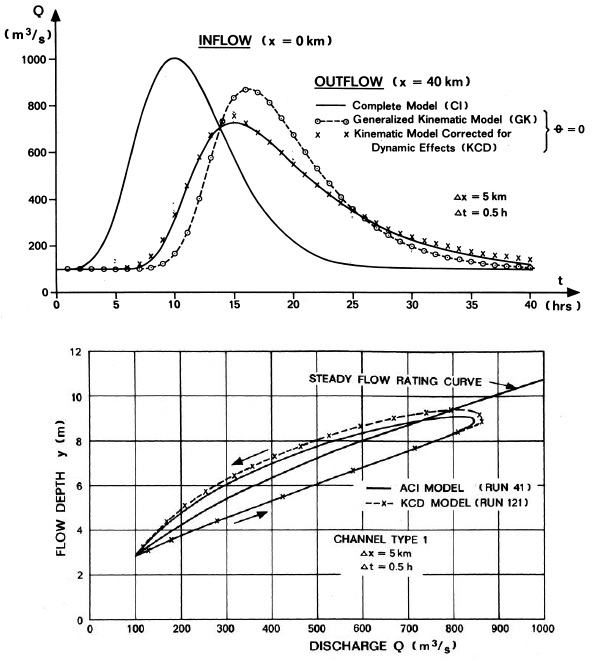
Fig. 1. Comparison of routing solutions, of the St. Venant equa- tions and of two diffusive-wave equivalent models, for a rapidly ris- ing wave through a prismatic channel of trapezoidal cross-section: (top) in- and outflow ( x =40km) hydrographs; (bottom) rating curves at x =20km. KCD=Kinematic wave Corrected for Dy- namic effects: y − Q conversions and c computed with the Jones Formula; GK=Generalised Kinematic: diffusive-wave equivalent, but y − Q conversions and c computed with the steady-flow rating curve (from Weinmann, 1977).